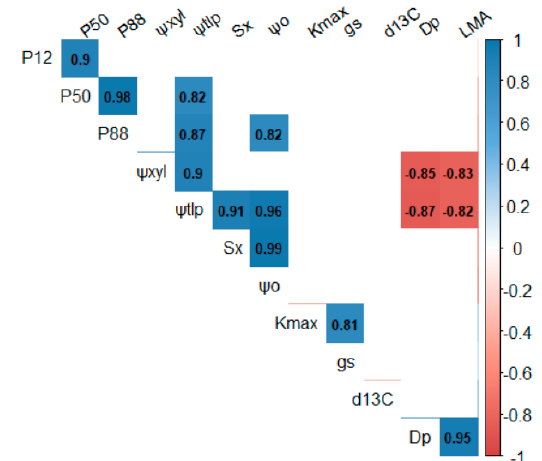
Figure 4. Correlogram. The value in each interaction box represents the Pearson correlation coefficient. Only significant associations ( p < 0.05; n = 6) are shown. Red and blue colors indicate whether the association is negative or positive, respectively, whereas the color intensity indicates the degree of significance. Variables: stomatal conductance (g s ), xylem water potential ( Ψ xyl ), leaf mass per area (LMA), petiole density (D p ), 13 C leaf isotopic composition (d 13 C), water potential at turgor loss point ( Ψ tlp ), osmotic potential at full turgor ( Ψ o ), maximum leaf hydraulic conductance (K max ), leaf water potential in which 12 (P 12 ), 50 (P 50 ) and 88% (P 88 ) of the leaf hydraulic conductance are lost, and slope of the vulnerability curve (S x